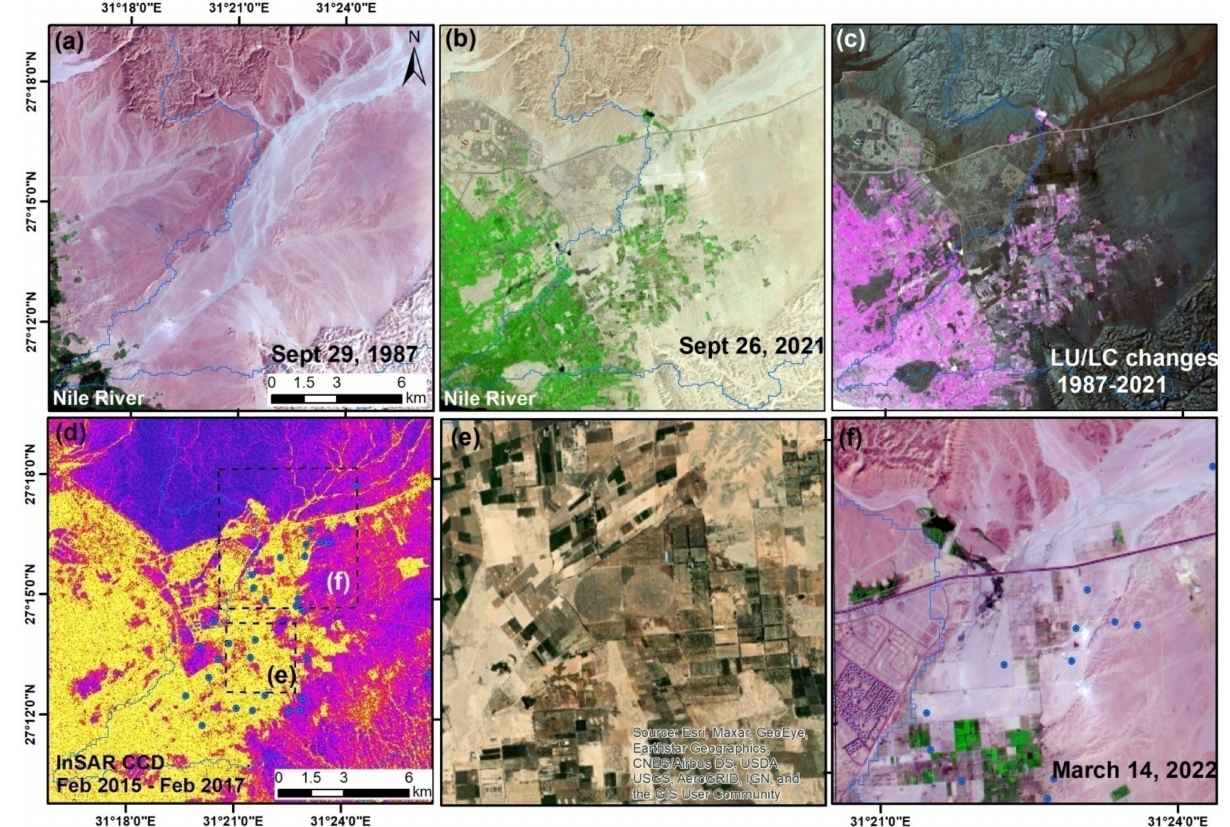
Figure 12. ( a ) Landsat-5 band composite data from bands 7, 4, and 2 from 29 September 1987; ( b ) Landsat-OLI band composite 7, 5, and 3 band composite data from 26 September 2021; ( c ) Dif- ference image between 1987 and 2021; ( d ) InSAR CCD data from February 2015–February 2017; ( e ) subset of GeoEye-1 as marked by the dashed black polygon in figure ( c ); ( f ) a subset of Landsat overlain by wells in blue